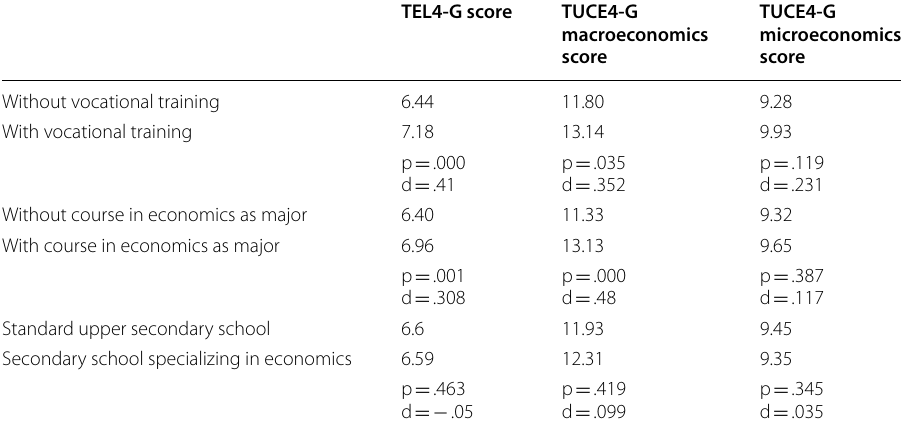
Table 3 T-tests for the different learning